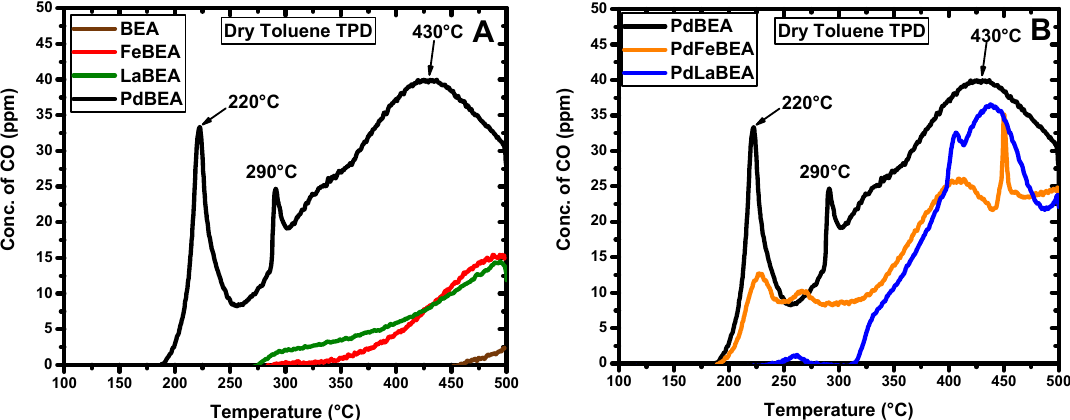
Figure 7. Temperature-programmed desorption of toluene in dry conditions where the concentration of formed CO is plotted against the corresponding temperature for ( A ) BEA, Fe / BEA, La / BEA, and Pd / BEA; and ( B ) Pd / BEA, Pd / Fe / BEA, and Pd / La / BEA.